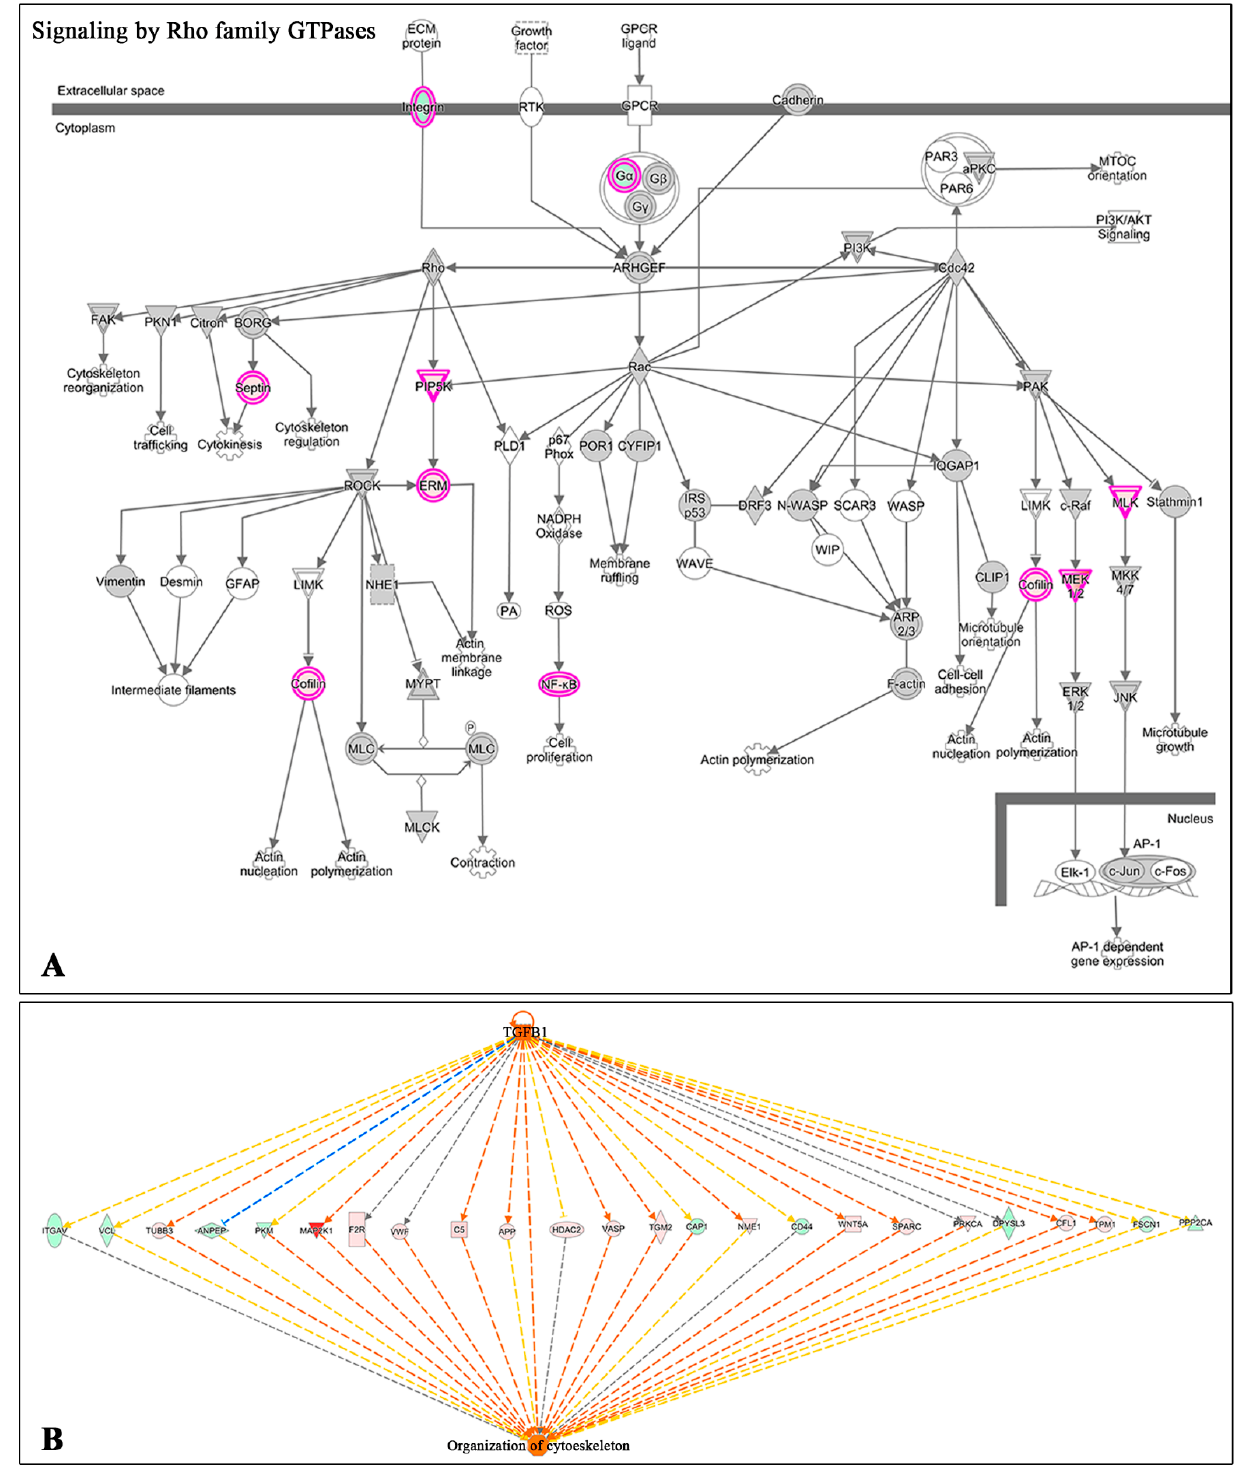
Figure 5. IPA analysis of differentially expressed proteins related to actin cytoskeleton activation. ( A ) Signaling cascade of Rho Family GTPases pathway. Red circles represent over-expression of proteins in HK ells treated with undiluted AS. ( B ) IPA upstream/downstream analysis link some differentially expressed proteins with the activation of HK cells by TGF- β 1 and the activation of the cytoskeleton organization.